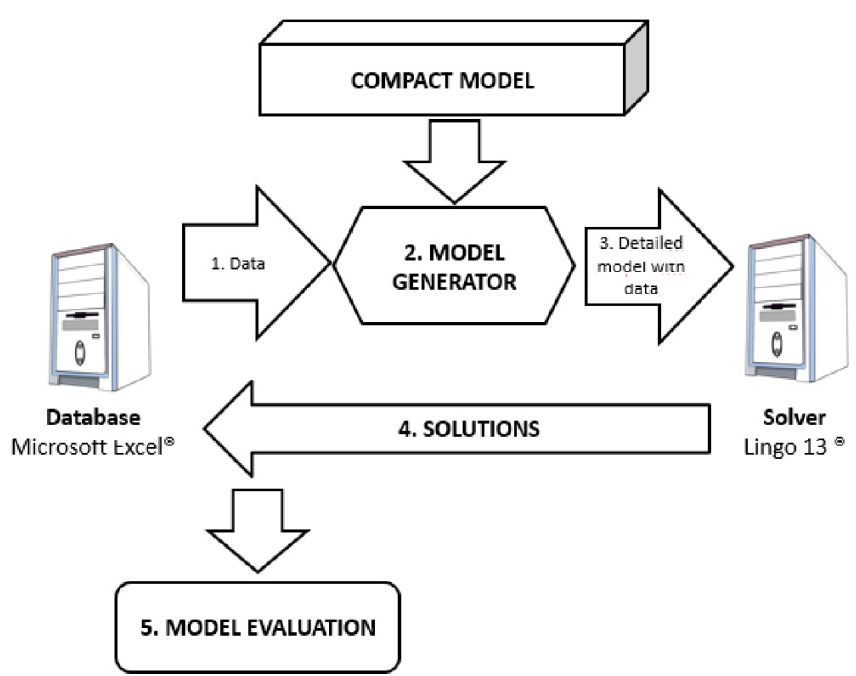
Figure 4. Diagram of computational experiments (adapted from Mula et al. 2010)